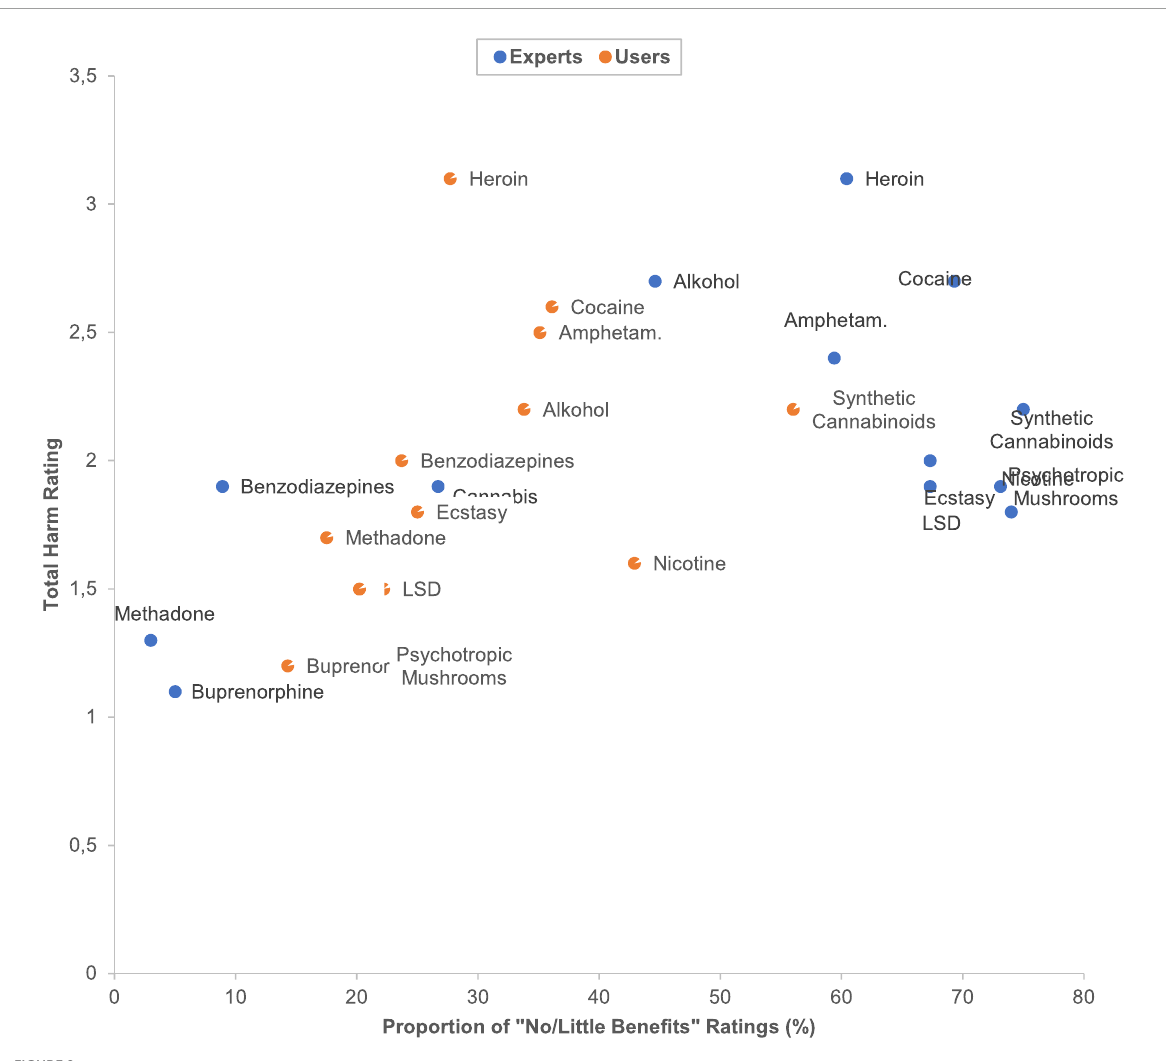
FIGURE9 Scatterplot of the users’ and experts’ overall substance harm/benefit ratios. The underlying data are shown in Supplementary Table 2 . The users’ cannabis rating point is masked by the users’ LSD rating point. The experts’ nicotine rating point is masked by the experts’ psychotropic mushrooms rating